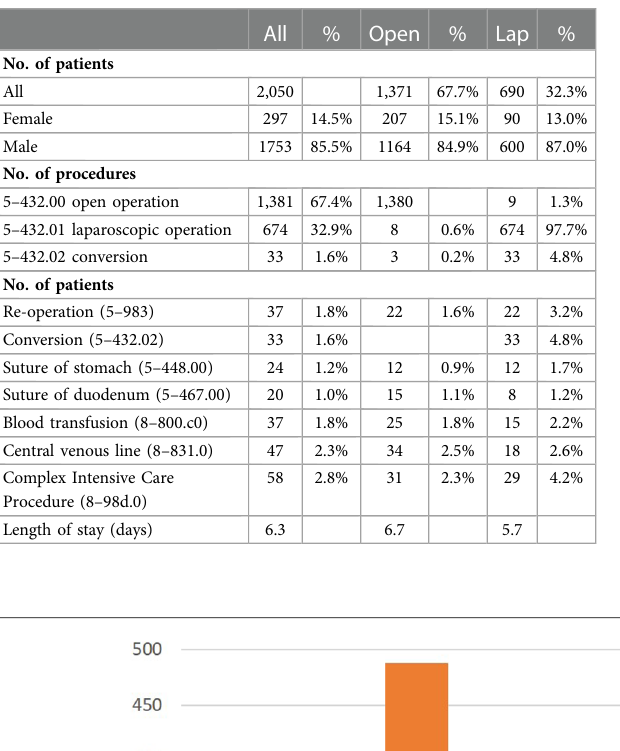
TABLE 1 Clinical characteristics of children who underwent open (5 – 432.00) or lap aroscopic (5 – 432.01 and 5 – 432.02) pyloromyotomy in Germany 2019 – 21. All procedures were assigned to patients not to procedures. 11 patients had both kind of procedures.